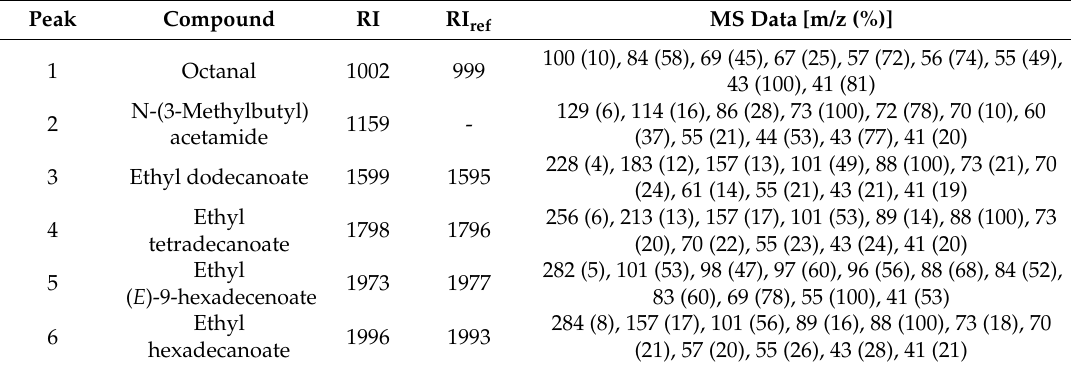
Table 1. Chemical compounds identified by GC-MS of rectal glands in female and male B.